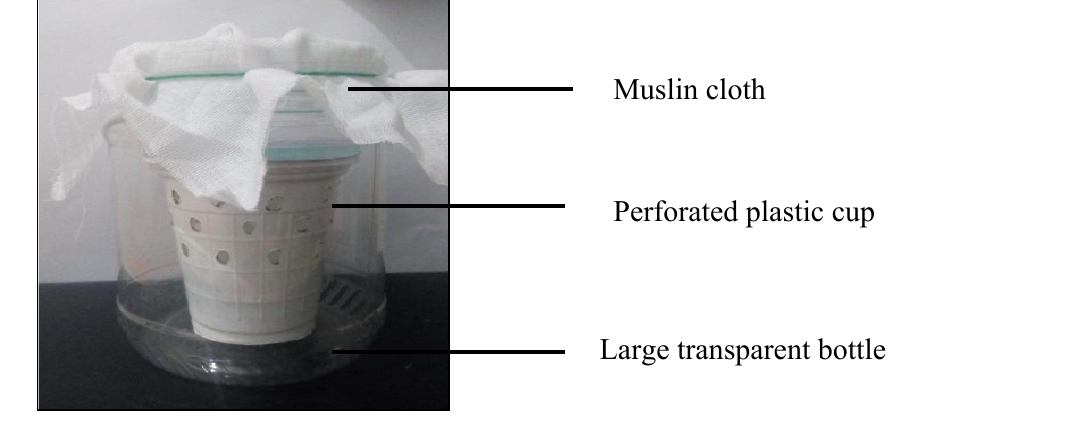
Figure 2: 020406080100 0